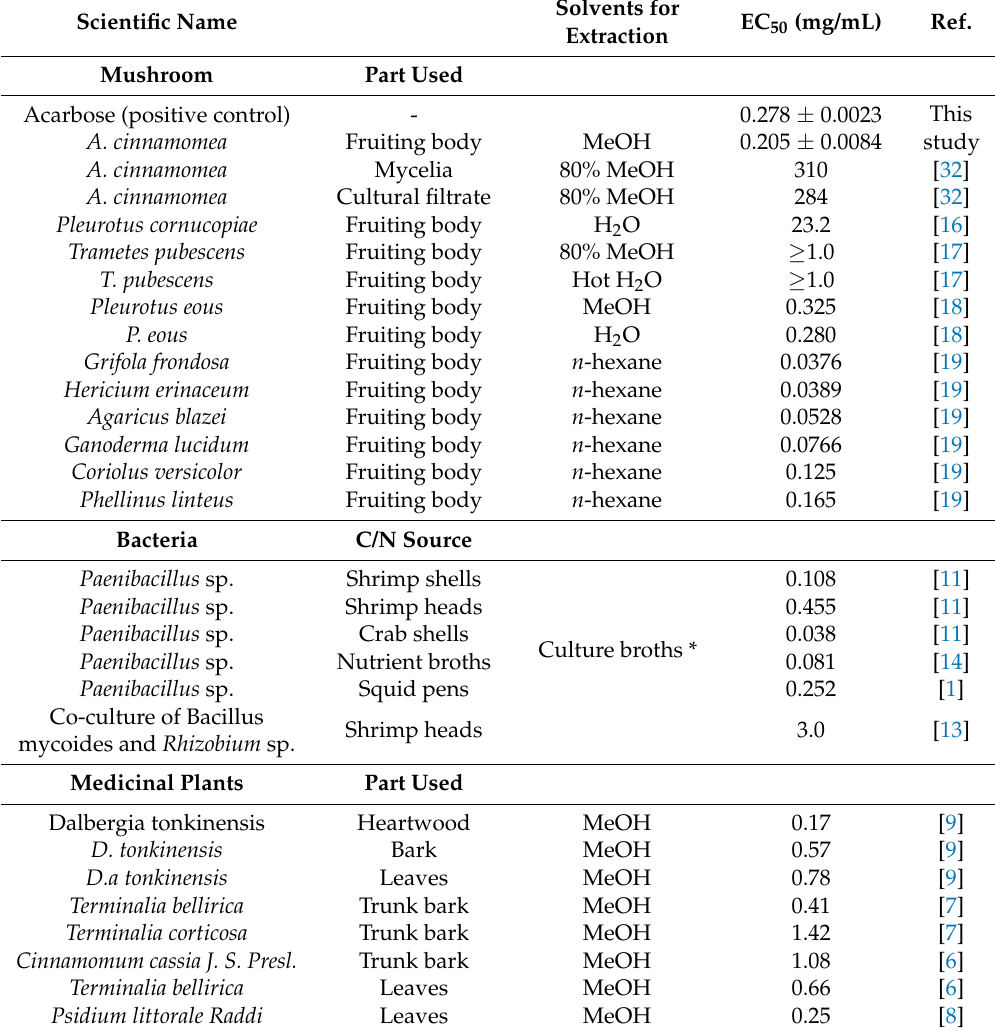
Table 1. α -glucosidase inhibition by recently reported natural source